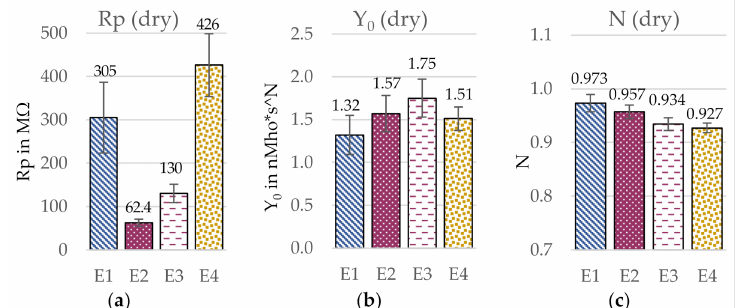
Figure 9. Influence of the electrode construction on the simulated circuit elements. ( a ) Charge transfer resistance Rp, ( b ) CPE admittance Y 0 , and ( c ) empirical constant N in dry condition. Estimated error indicated with error bars. Goodness of fit χ 2 (E1) = 16.9; χ 2 (E2) = 10.5; χ 2 (E3) = 10.2; χ 2 (E4) = 8.1.